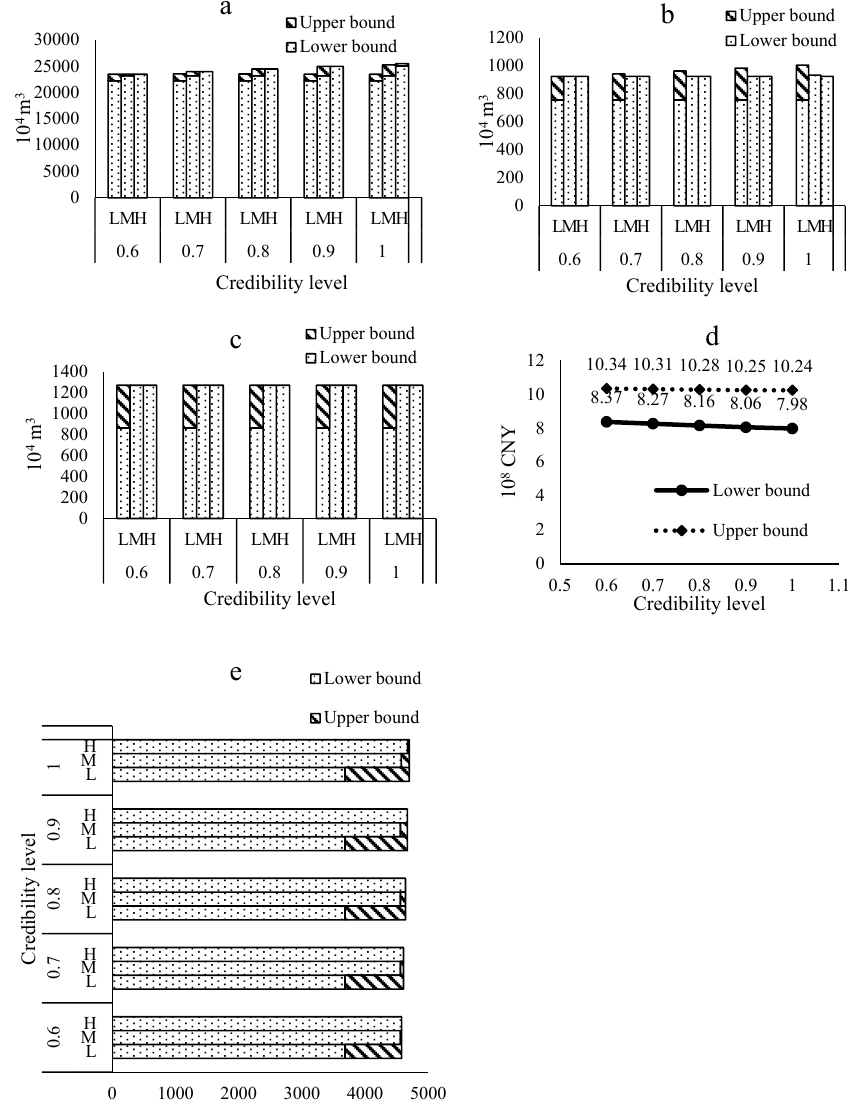
Figure 4. Water distribution optimization results of PI ( a ), SI ( b ), TI ( c ), the total cost ( d ) and total COD